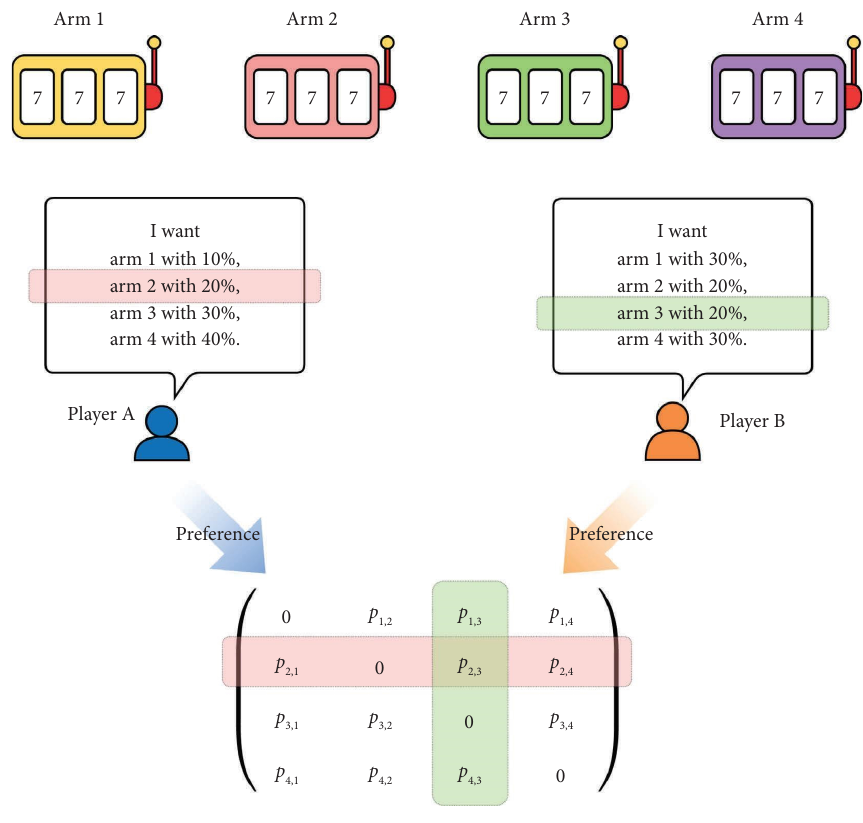
Figure 2: Problem settings. Te sum of each row should be close to the corresponding preference of player A, and the sum of each column should be close to the corresponding preference of player B.